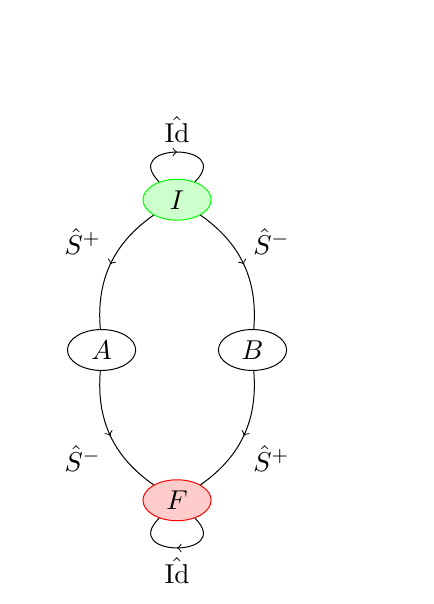
) of the XX model ˆ H XX ... A are left r 1